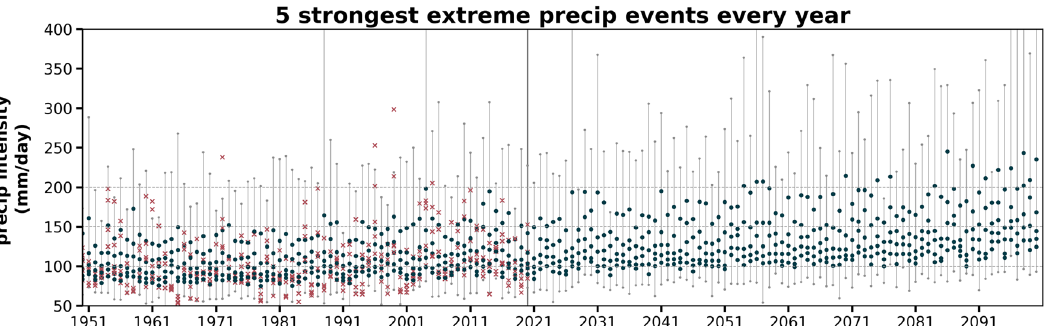
Fig. 4 Five strongest extreme precipitation events in the NEUS autumn from 1951 to 2100. Blue color dots are the intensity of the annual fi ve strongest events in the ensemble mean of SPEAR_HI historical (1951 – 2014) and SSP5-8.5 (2015 – 2100) simulations. Thin gray lines indicate the ensemble spread of the fi ve strongest events in each ensemble member each year. Pink crosses are the intensity of the annual fi ve strongest events from the observations. The vertical black line indicates the year of 2020. The time series is not smoothed with a 7-year running mean as in Fig. 2, since the context is to emphasize the strong internal variability of extreme precipitation.